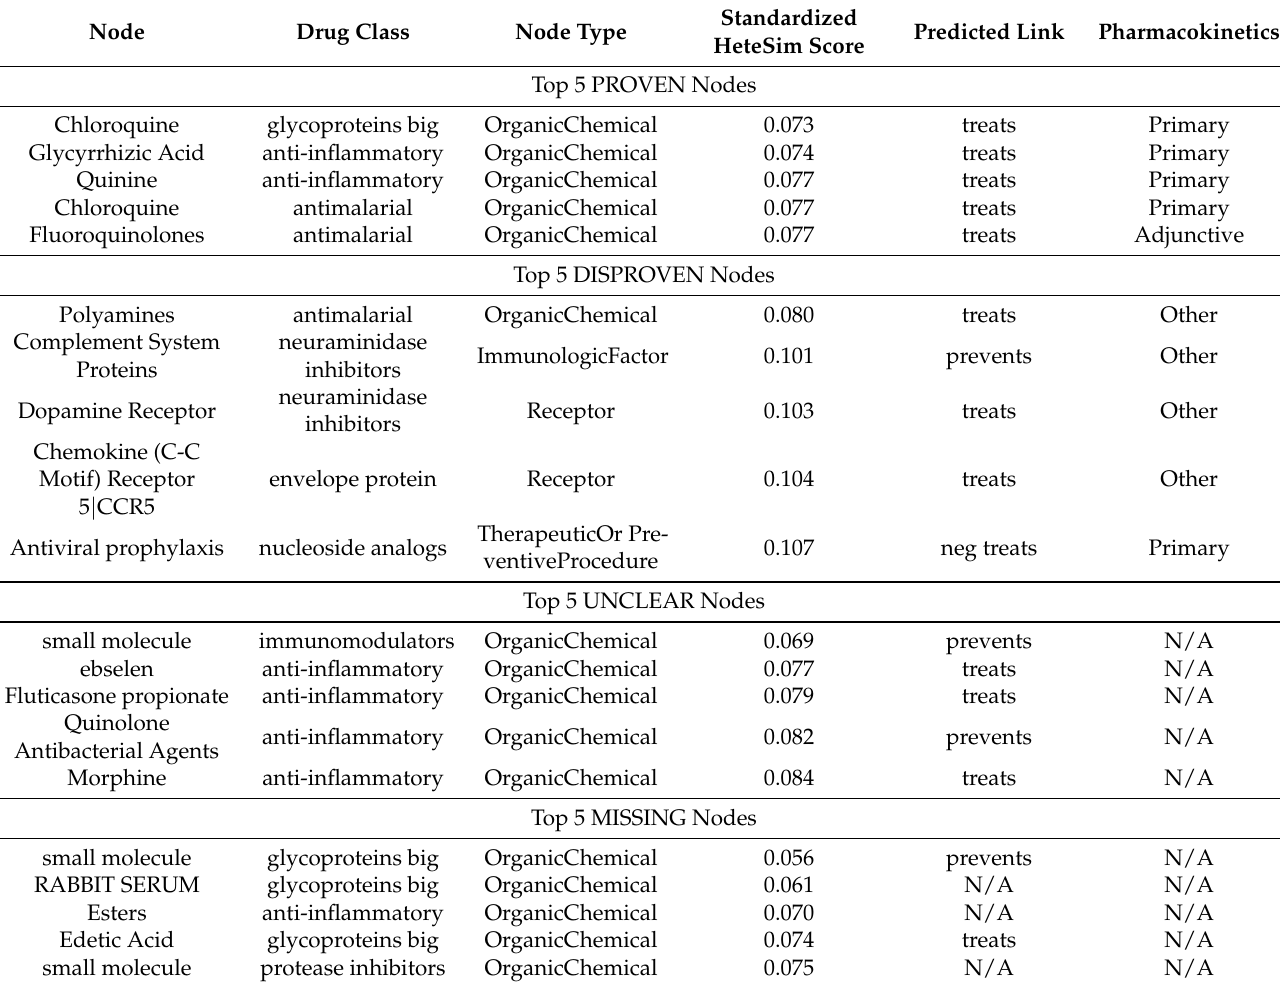
Table 5. The top 5 nodes with each link prediction validation label, ranked by lowest HeteSim scores. Lower standardized HeteSim scores corresponds to a stronger relationship. The complete list of top ranked nodes (n = 180, equivalent to the top 20 ranked nodes for each node type) can be found in Supplementary Table